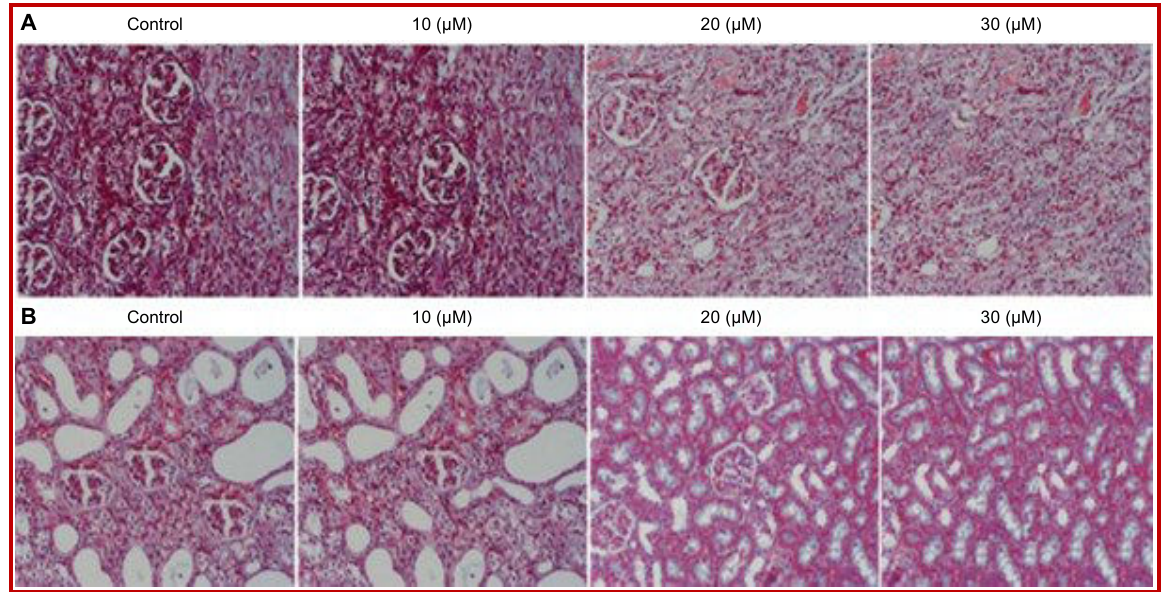
Figure 5: Histopathological examination of lung and intestinal tissues of rats bearing orthotopictumours following ludartin treat- ment. The rats in the treatment group were given 30 µM/kg doses of ludartin for 15 days daily. The lung and intestinal tissues were stained using HE staining and then subjected to histopathological